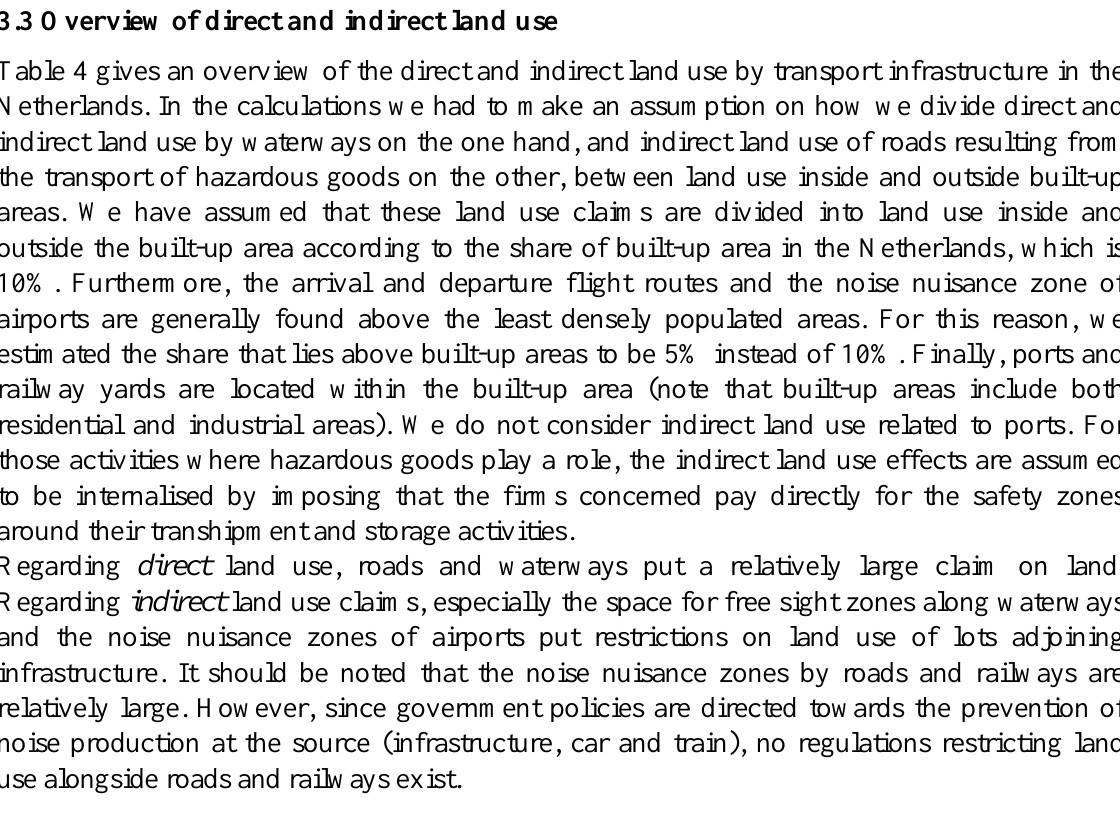
Table 4. Overview of direct and indirect land use by infrastructure in the Netherlands,